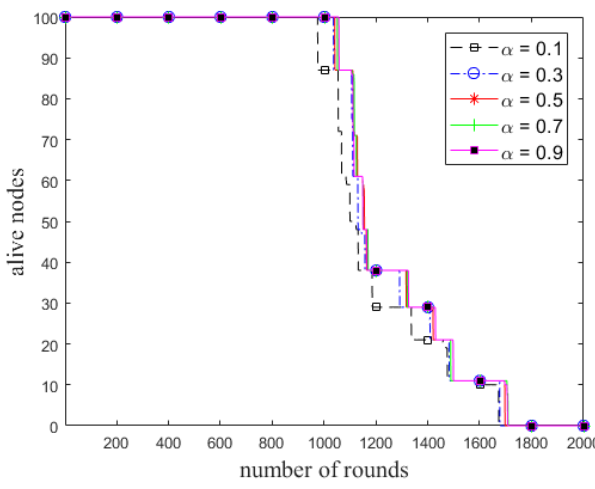
Figure 5. Number of alive nodes in each round in ECCR.